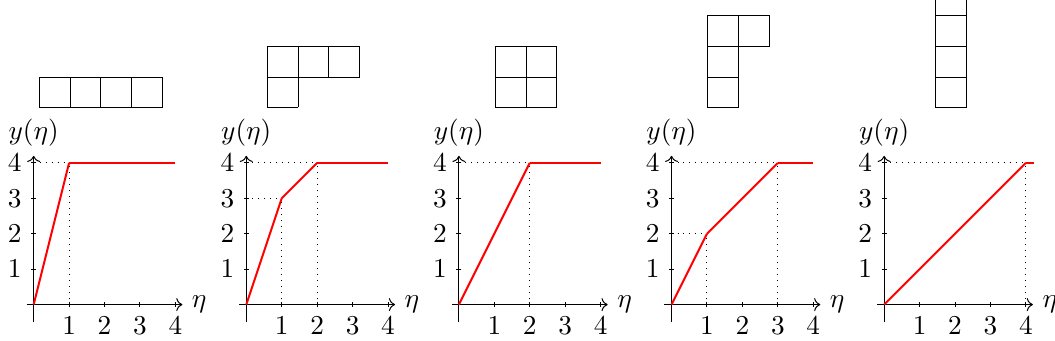
Figure 4 . The Young diagrams and accompanying piecewise linear functions for N = 4 . The first diagram from the left represents a maximal puncture, the third is a Z 2 singularity, the fourth is a minimal puncture, while the rightmost diagram corresponds to a regular